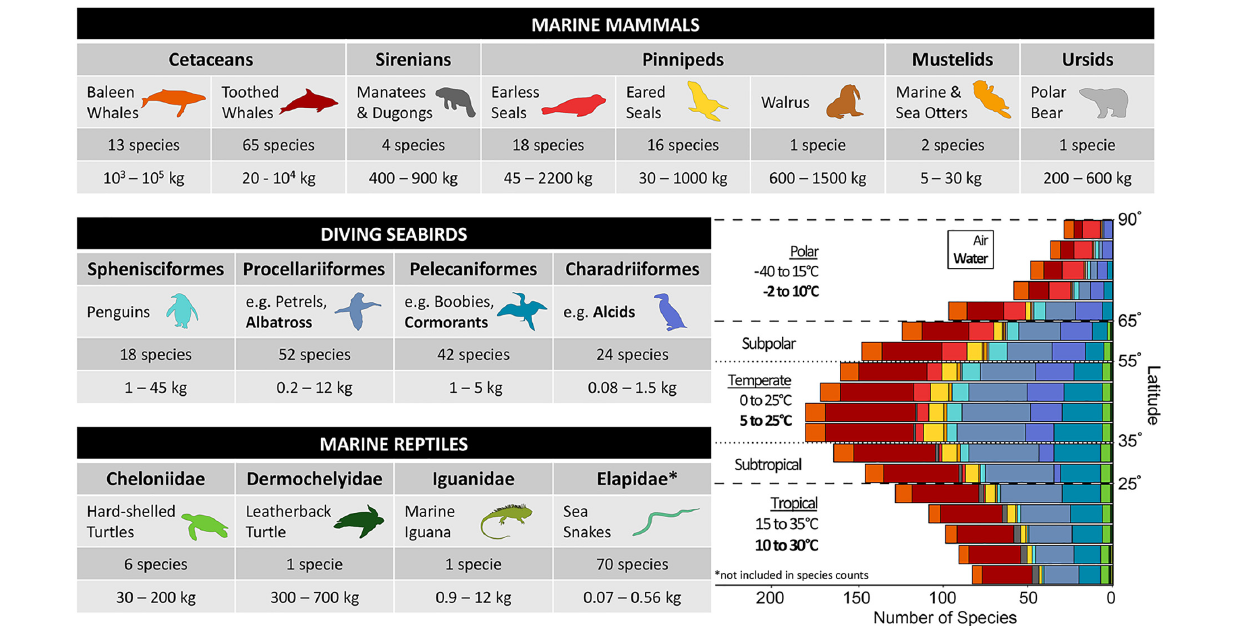
FIGURE 2 | Marine air-breathing vertebrates are comprised of the following groups: marine mammals, seabirds, and marine reptiles. The table includes the common name used in the remainder of the review for each taxonomic group (representative bolded species are used for seabird orders that do not have an all-encompassing common name).The number of species and mass range for each taxonomic group are provided and include species considered to be true air-breathing divers (full list of species and mass references in Supplementary Table S1 ), all of which are included in the bar graph, with the exception of Elapidae. Refer to the text in section “Diverse Divers Face a Common Challenge” for further explanation about which groups are discussed in the review. The bar graph in the lower right shows the distribution of species grouped by taxa across absolute latitude using 5 ◦ bins (species counts provided in Supplementary Table S2 ). The habitat range classifications (Tropical, Subtropical, Temperate, Polar, and Subpolar) are defined based on the following absolute latitudes (0–25 ◦ , 25–35 ◦ , 35–55 ◦ , 55–65 ◦ , and 65–90 ◦ ) and denoted by dashed lines. Air and water temperature ranges are provided for polar (including subpolar), temperate, and tropical (including subtropical) habitat ranges. The greatest number of diving air-breathers are found at mid-latitudes (i.e., temperate, subtropical, and subpolar), where temperatures are more moderate compared to equatorial and high latitudes. Monthly mean air and sea surface temperature data were obtained from ICOADS data products provided by the NOAA/OAR/ESRL Physical Sciences Laboratory (https://psl.noaa.gov/data/gridded/data.coads.1deg.html). Temperatures in the winter and summer months (e.g., summer months: January, February, March in the Northern Hemisphere and July, August, September in the Southern Hemisphere) were used to estimate minimum and maximum average temperatures in each region. Distribution maps for 264 species were used: 13 Mysticeti, 65 Odontoceti, 4 Sirenia, 18 Phocidae, 16 Otariidae, 1 Odobenidae, 2 Mustelidae, 1 Ursidae, 18 Sphenisciformes, 52 Procellariiformes, 42 Pelecaniformes, 24 Charadriiformes, 6 Cheloniidae, 1 Dermochelyidae, and 1 Iguanidae. Distribution maps obtained from